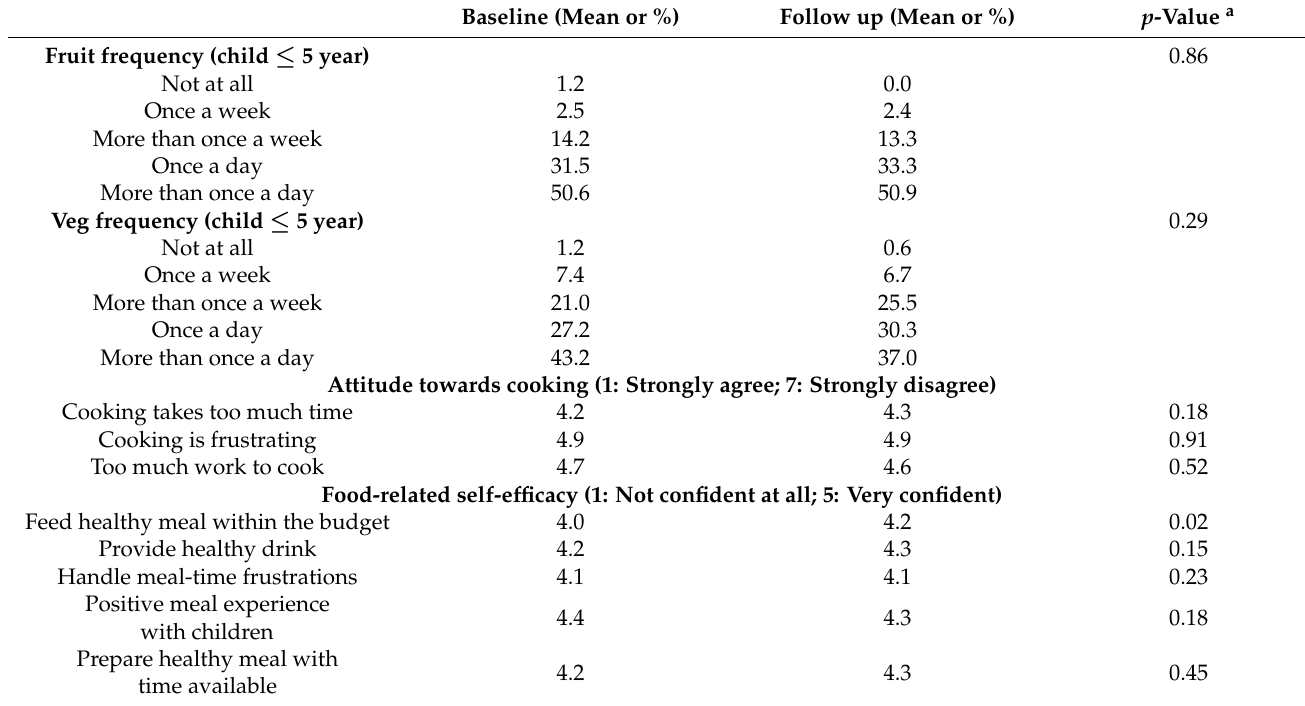
Table 2. Food-related behaviors and attitudes in baseline and follow-up surveys among new Cooking Matters Facebook followers ( n